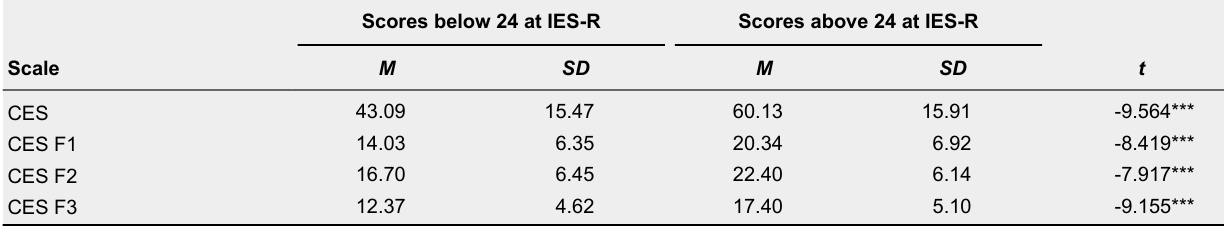
Difference in CES Scores Between Adolescents That Obtained Scores Below and Above the IES-R Cut-Off of 24 Scores below 24 at Scale